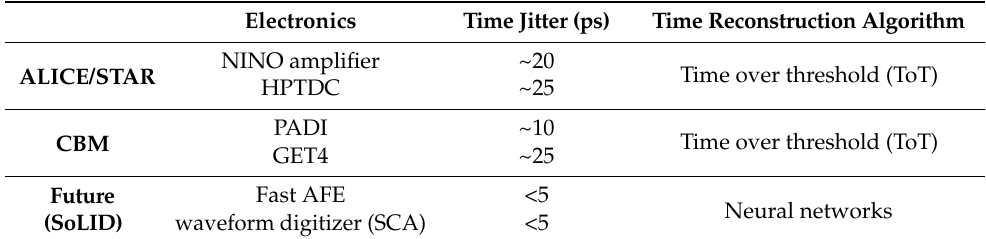
Table 4. Summary of the electronics and timing methods for MRPC